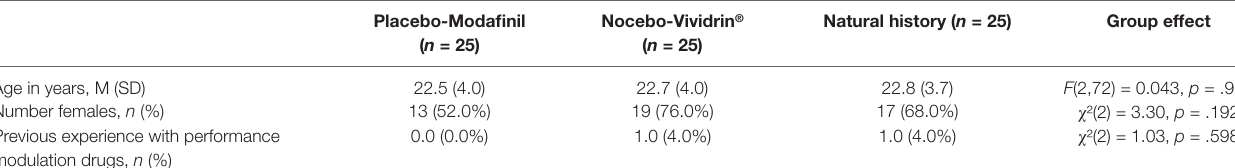
TABLE 1 | Sample characteristics at